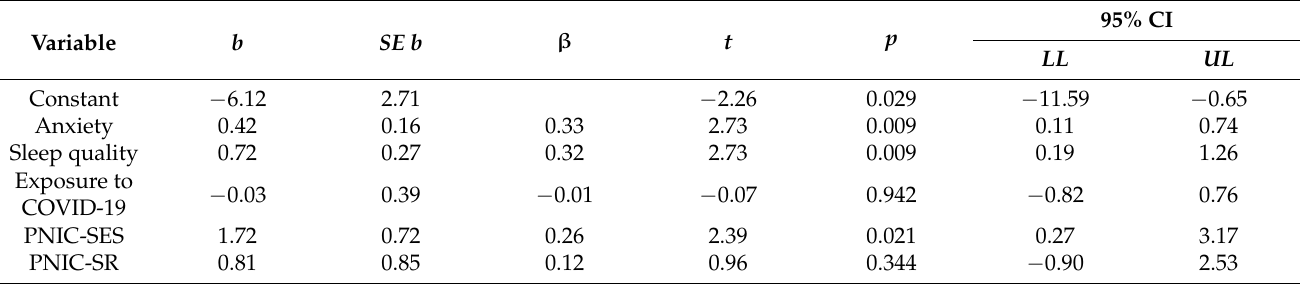
Table 5. Results of linear regression analysis for depression ( N = 207).